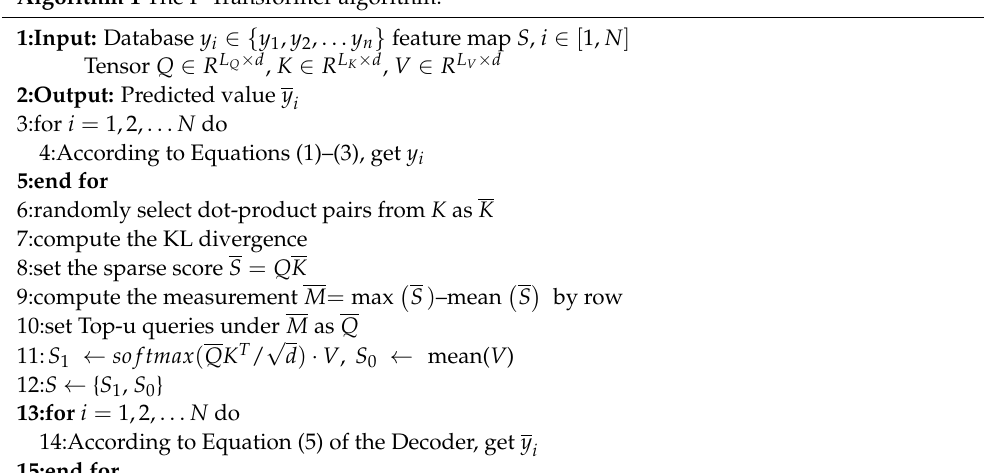
Algorithm 1 The P-Transformer algorithm.